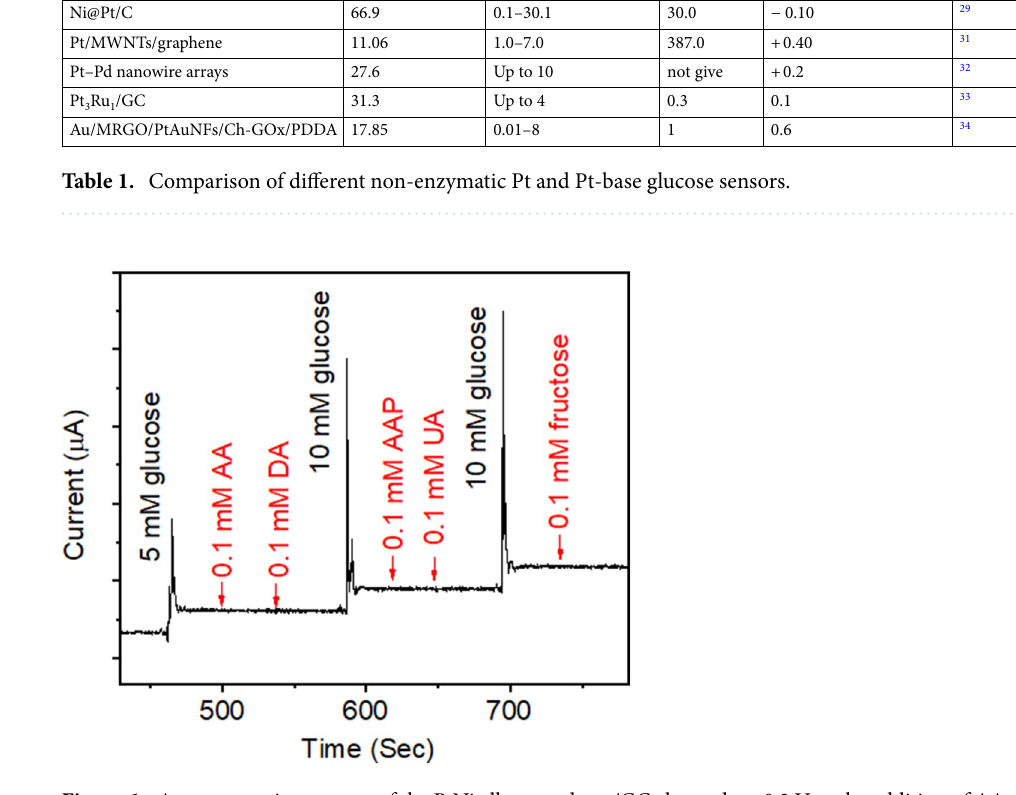
Figure 6. Amperometric response of the PtNi alloy-graphene/GC electrode at 0.3 V to the addition of AA, DA, AAP, UA, fructose and